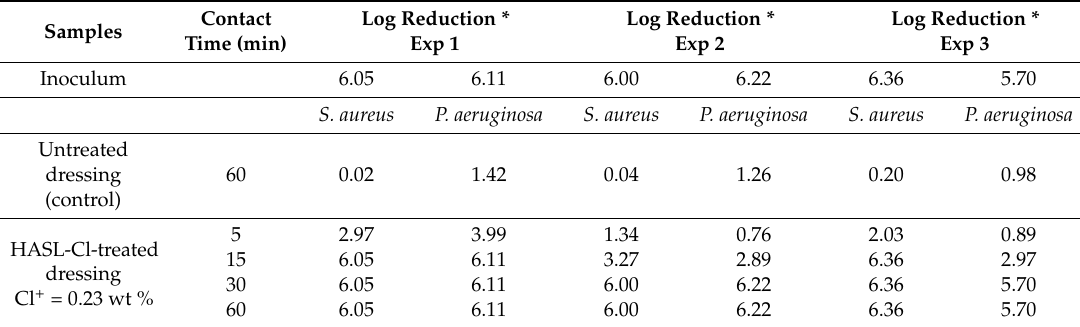
Table 5. Biocidal efficacy of HASL-Cl coated wound dressings.